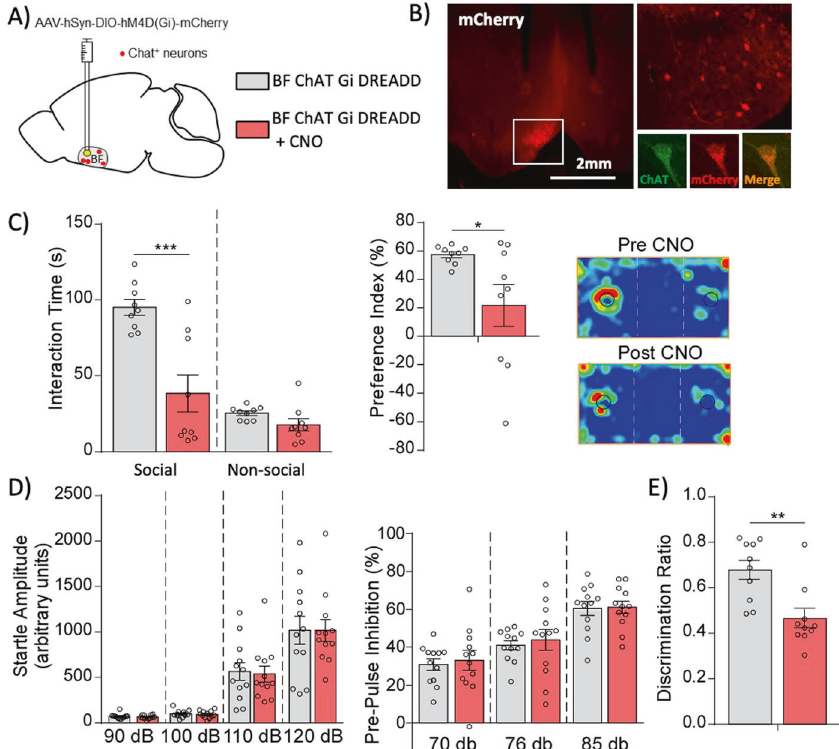
Fig. 4 Chemogenetic inhibition of BF cholinergic neurons in healthy animals induces social and cognitive de fi cits. A Schematic representation of stereotaxic delivery of Gi-coupled hM4D inhibitory fl oxed DREADD AAV (mCherry-tagged) into the basal forebrain of Chat CRE mice. B mCherry signal in the BF con fi rming recombination (upper right: zoomed in image, lower right: individual cholinergic neuron). C Induction of social preference de fi cits after inactivation of BF cholinergic neurons of control mice after CNO administration ( n = 9, Interaction time: F interaction (1, 32) = 12.56, p = 0.0012, F zone (1,32) = 42.27, p < 0.0001, F treatment (1,32) = 21.58, p = 0.0001, two-way ANOVA; Preference index: t(16) = 2.40, p = 0.029, unpaired two-tailed t-test). Inset: Representative heat maps. D Startle response and sensory gating processing are not affected by BF cholinergic neuron inhibition ( n = 12, Startle: F interaction (3, 66) = 0.014, p = 1.0; F stimulus (3, 66) = 86.67, p < 0.0001; F treatment (1, 22) = 0.017, p = 0.90; PPI: F interaction (2, 44) = 0.014, p = 0.09; F stimulus (2, 44) = 57.12, p < 0.0001; F treatment (1, 22) = 0.16, p = 0.70, two-way RM ANOVA). E Reduced discrimination ratio in the temporal order recognition memory (TORM) test after inhibiting BF cholinergic neurons ( n = 10, t(18) = 3.58, p = 0.0021, unpaired two-tailed t-test). Š idák ’ s post-hoc test was used for multiple comparisons. In all panels, * p < 0.05; ** p < 0.01; *** p <